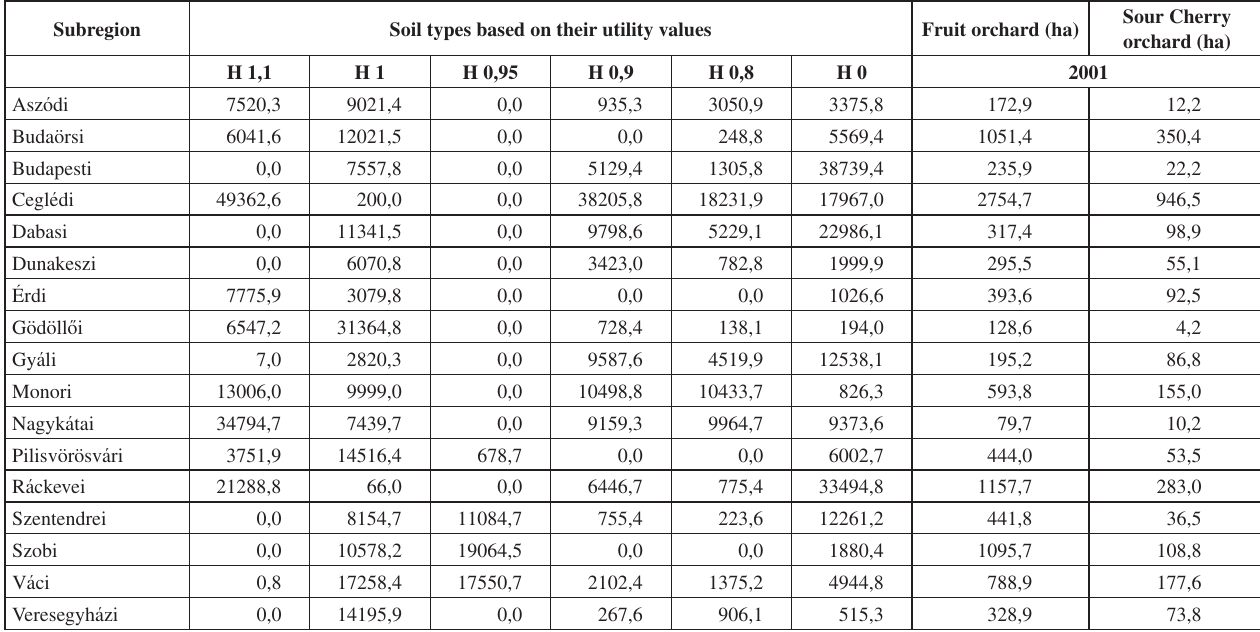
Table 3. Areas (ha) of the different soil types, fruit growing and sour cherry production in the subregions Subregion Soil types based on their utility values Fruit orchard